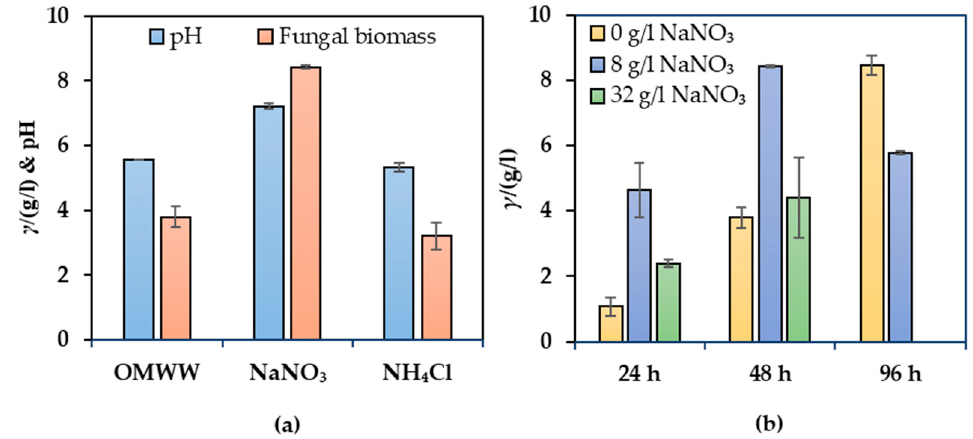
Figure 4. ( a ) Effect of nitrogen source on biomass mass concentration and pH following 48 h cultivation of A. oryzae in undiluted OMWW at initial pH of 5.2; ( b) Effect of mass concentration of NaNO 3 on biomass mass concentration following cultivation of A. oryzae in undiluted OMWW at initial pH of 5.2 for 24 h, 48 h, and 96 h.